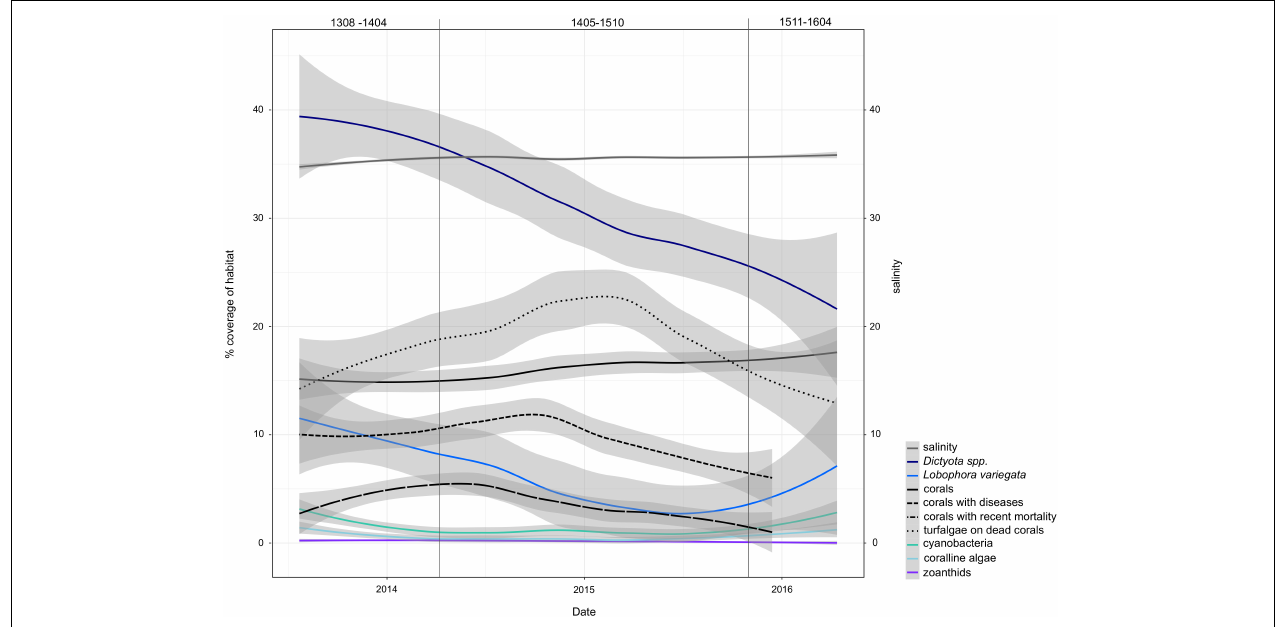
FIGURE 6 | Trends of environmental variables during the high-resolution sampling period at USVI. Variability of data is smoothed for better visibility of patterns using local polynomial regression fitting in the ggplot2 function “geom_smooth.” Vertical lines mark the periods dominated by the three distinct genetic clusters of G. caribaeus . Cover corresponds to cover of benthos (out of